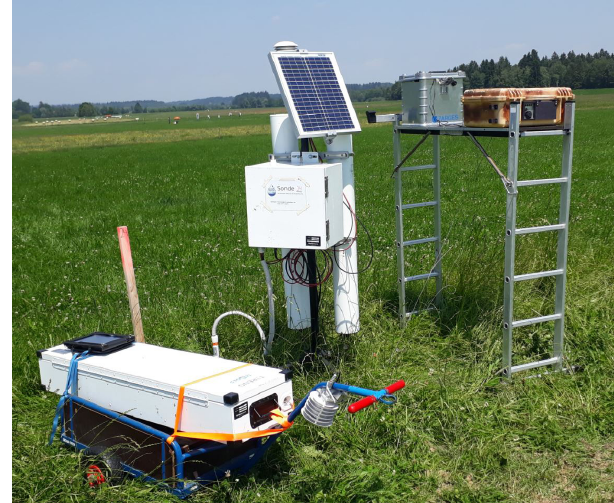
Figure 4. Intercalibration of the stationary sensor (middle) using the mobile rover on a hand wagon (left) and the mobile calibrator unit (right), with minimum record periods of 20min and 24h, re-